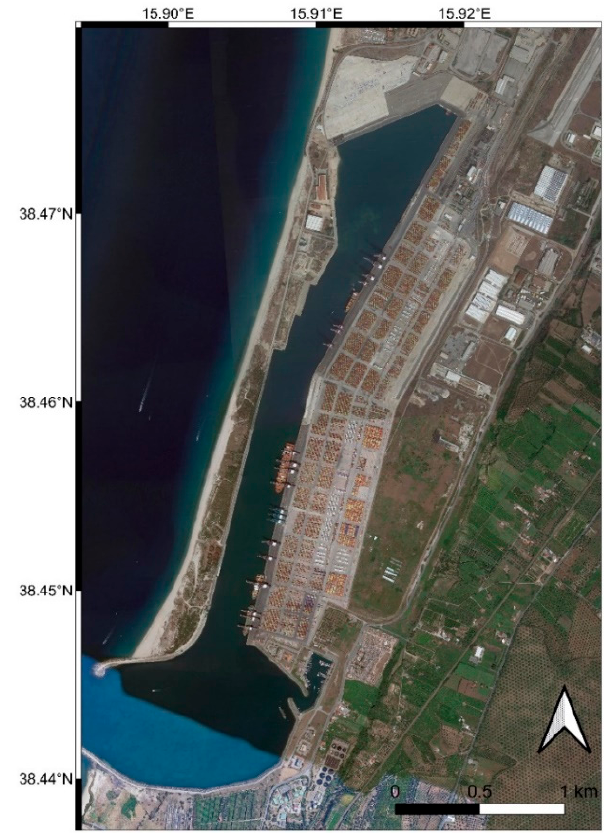
Figure 2. Satellite view of the port of Gioia Tauro